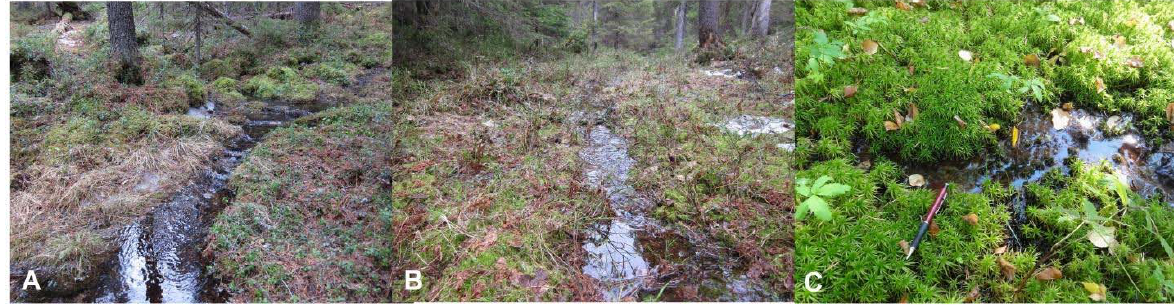
Figure 1. ( A , B ) Example of stream heads (trickles) during snowmelt; ( C ) Example of a stream head during base